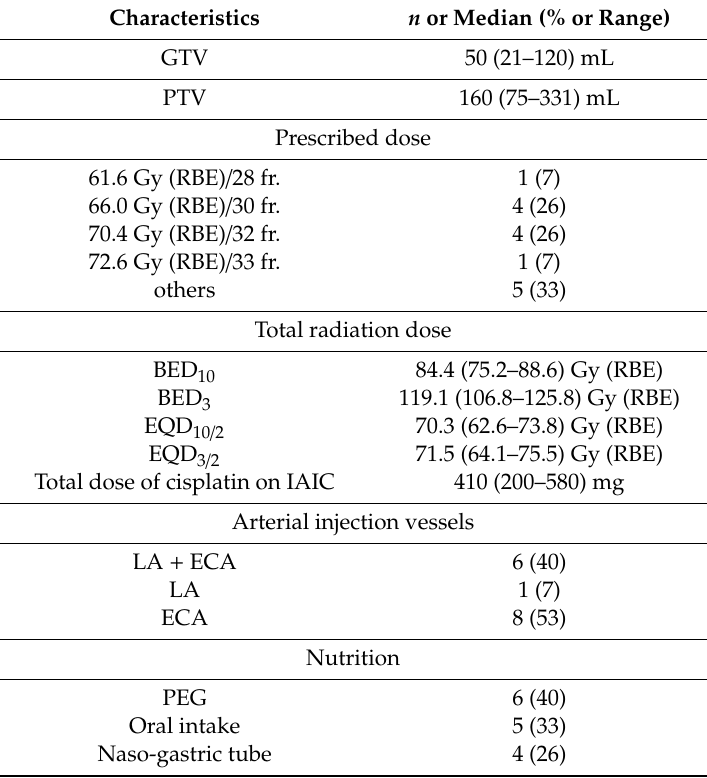
Table 2. Treatment